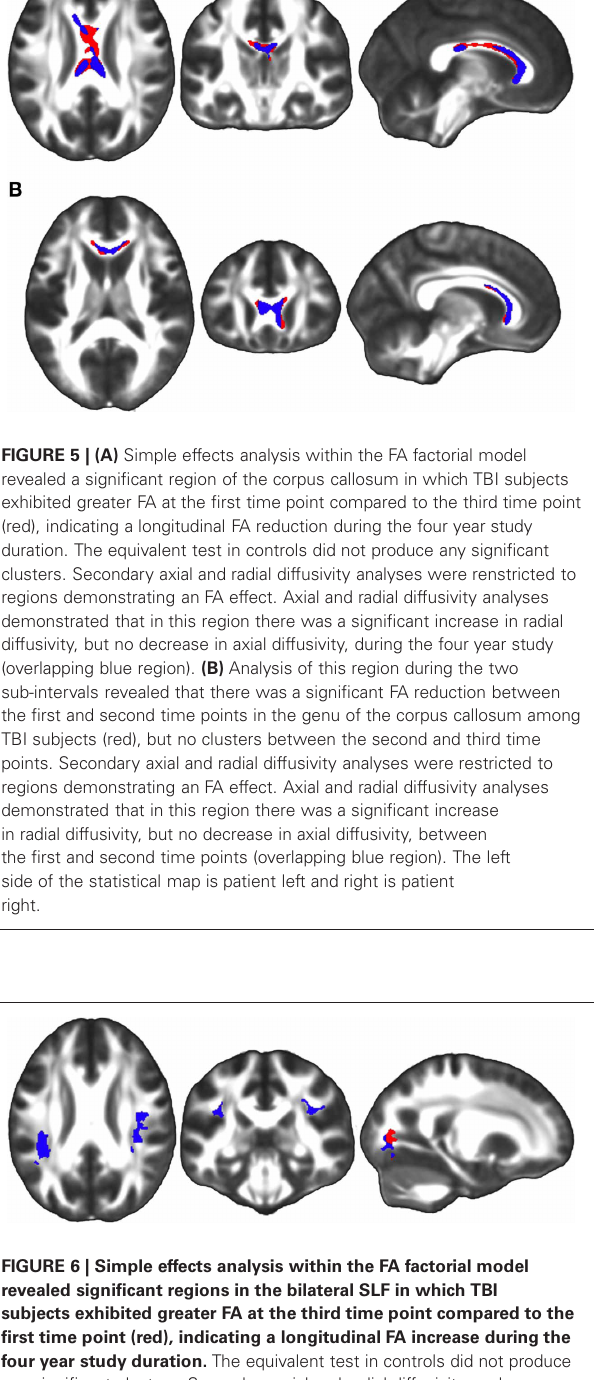
restricted to this region demonstrating an FA effect. Axial and radial diffusivity analyses demonstrated that in this region there was a significant decrease in radial diffusivity during the four year study period (overlapping blue region), but no accompanying increase in axial diffusivity. The left side of the statistical map is patient left and right is patient right.